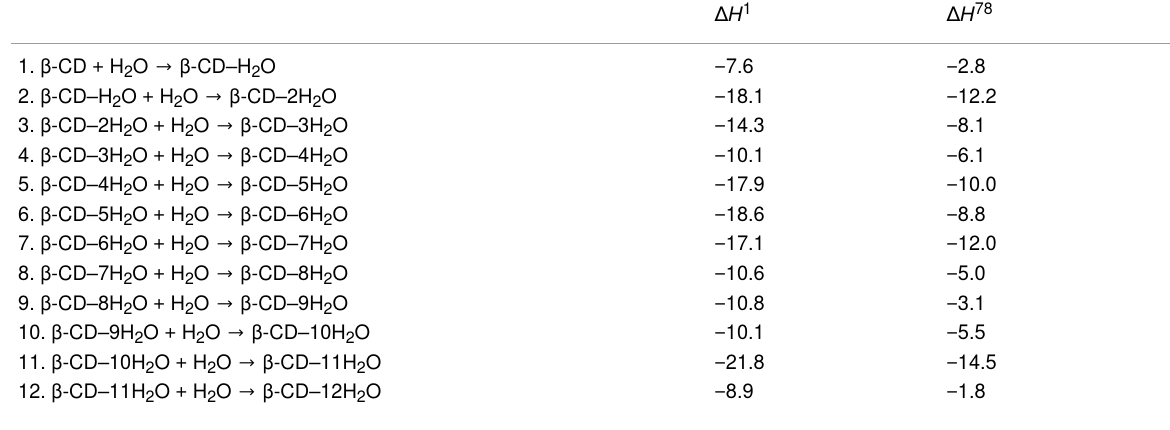
Table 1: Gas phase enthalpies ( Δ H 1 ) calculated at the M062X/6-31G(d,p) level of theory and enthalpies in water environment ( Δ H 78 ) (in kcal mol − 1 ) for the most stable β -CD– n H 2 O ( n = 1–12) complex formation.